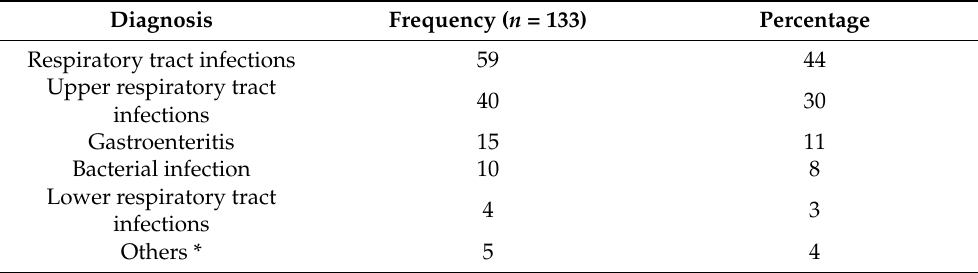
Table 5. Showing diagnoses that were considered noncompliant with the guidelines.